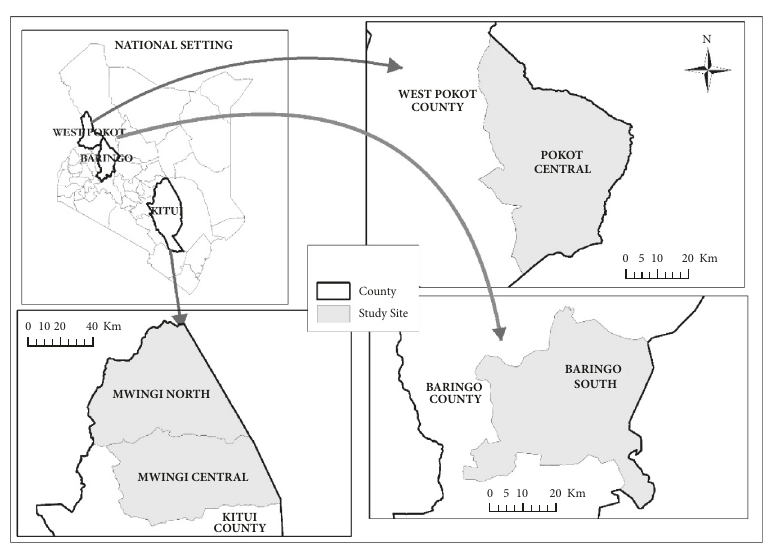
Figure 1: A map showing areas where honey samples were